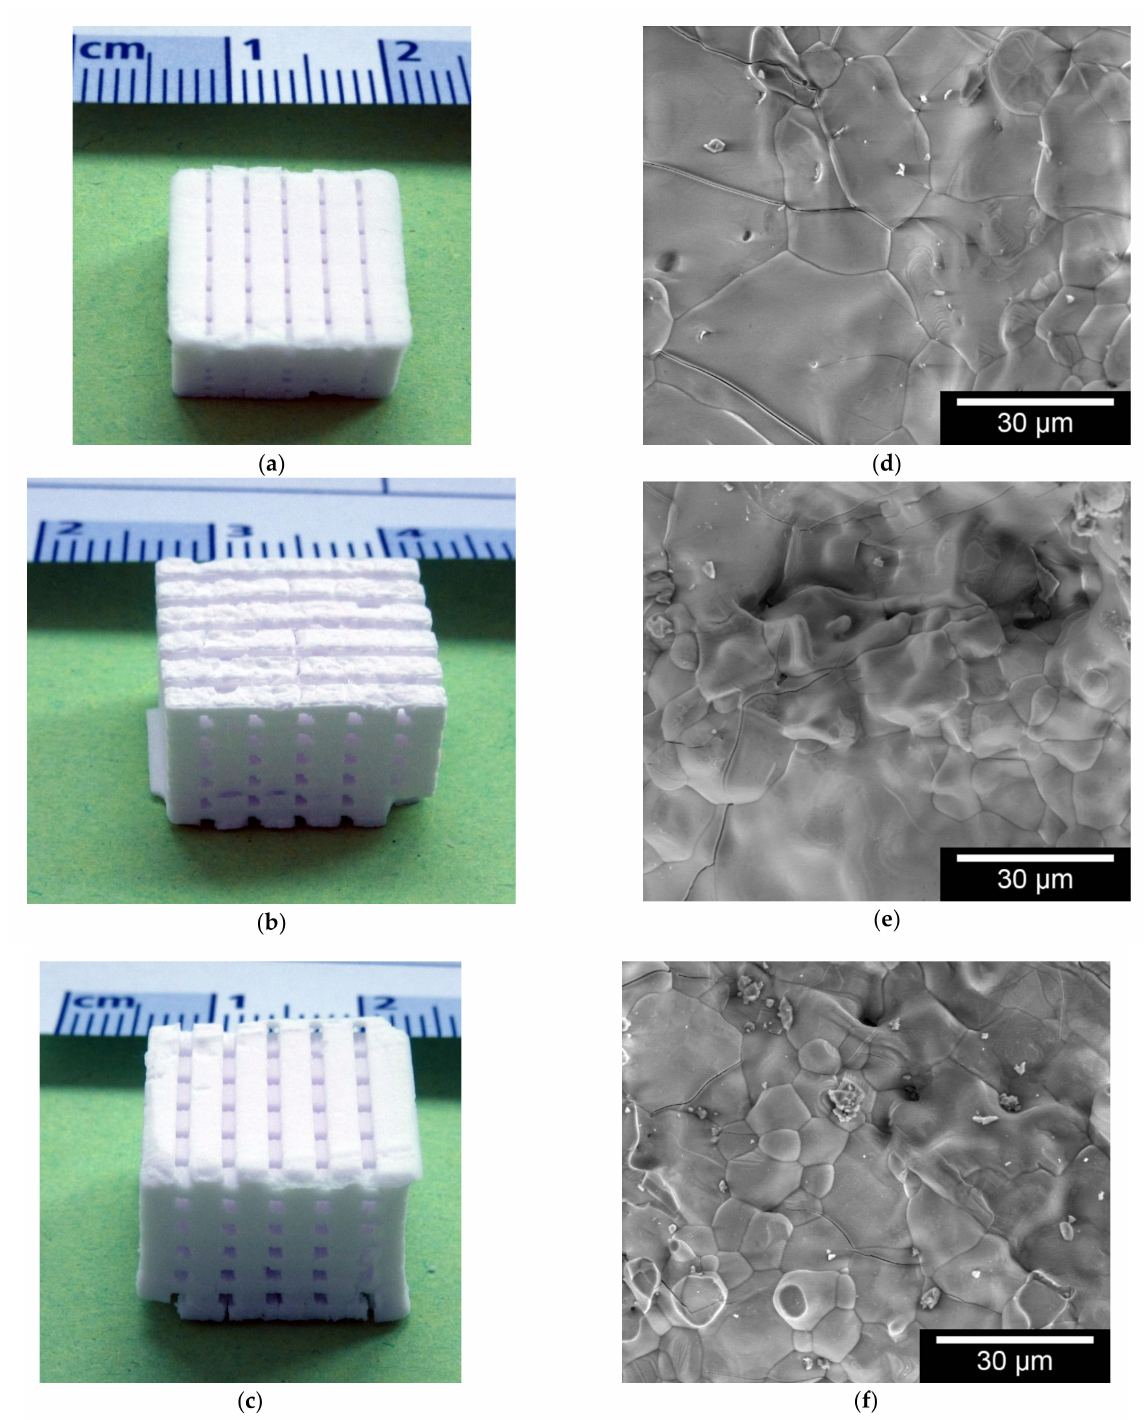
Figure 3. Macro and microstructure of the scaffolds; exemplary images of band width 2000 µ m three different pore sizes: ( a ) 500 µ m; ( b ) 750 µ m; and ( c ) 1000 µ m; microstructures taken with FEI QUANTA 250 FEG, 20 kV, 3200 × magnification (HFW 93.3 µ m) of the sample surface: ( d ) 500 µ m; ( e ) 750 µ m; and ( f ) 1000 µ